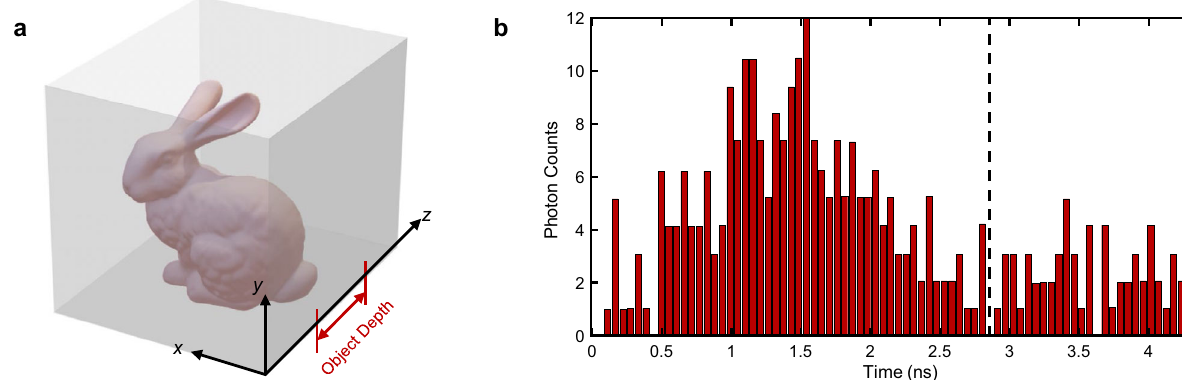
Fig. 4 Scenario layout and the temporal response in the fog. a The scenario layout of the target and the fog chamber. Taking the target ‘ Bunny ’ as an example, its depth range is 40 – 60 cm and the total depth of the fog chamber is 150 cm. The object depth range is de fi ned as the distance range between the object and the front surface of the media. b The temporal response at one of the scanning points is captured by the ultrafast detector in the scenario shown in ( a ). Affected by the time variability of the fog, the temporal response is disturbed by the dynamic noise. Since the backscattered light has little effect on signal photons in the fog, the photons re fl ected by the object and those do not reach the object can be distinguished in the temporal response taking depth as a prior as the dashed line